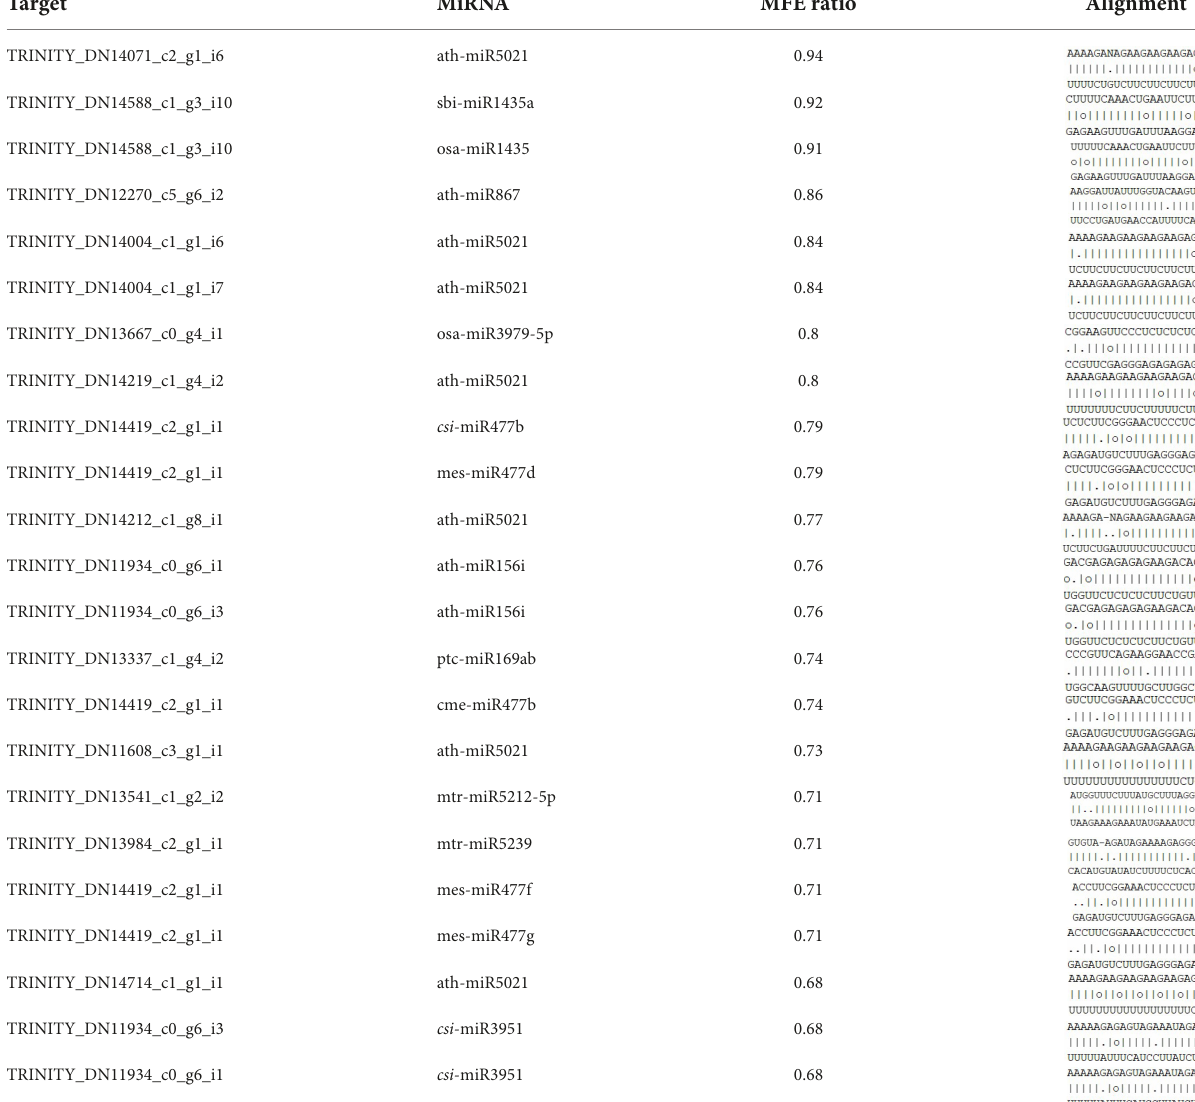
TABLE 2 Complementary pairing of lncRNAs targeted by miRNAs in